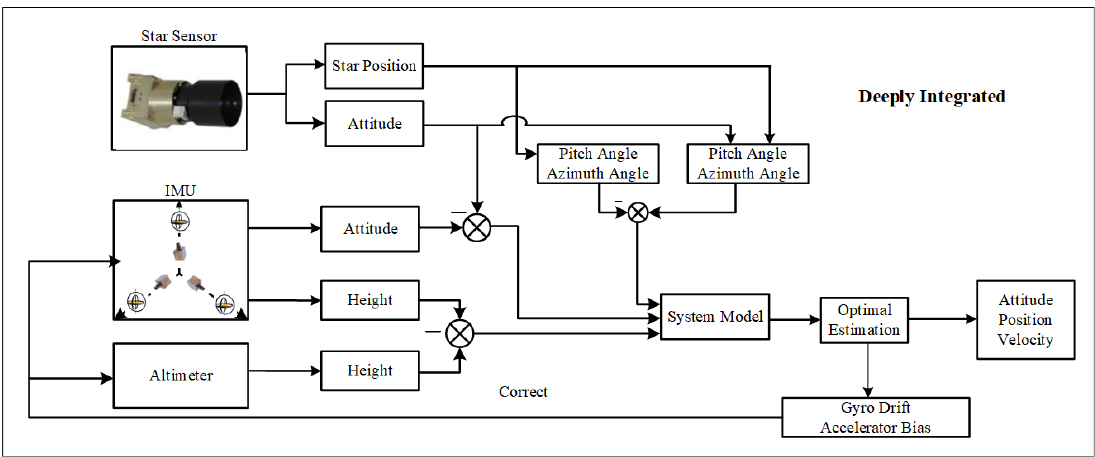
Figure 2. SINS/CNS deeply integrated navigation